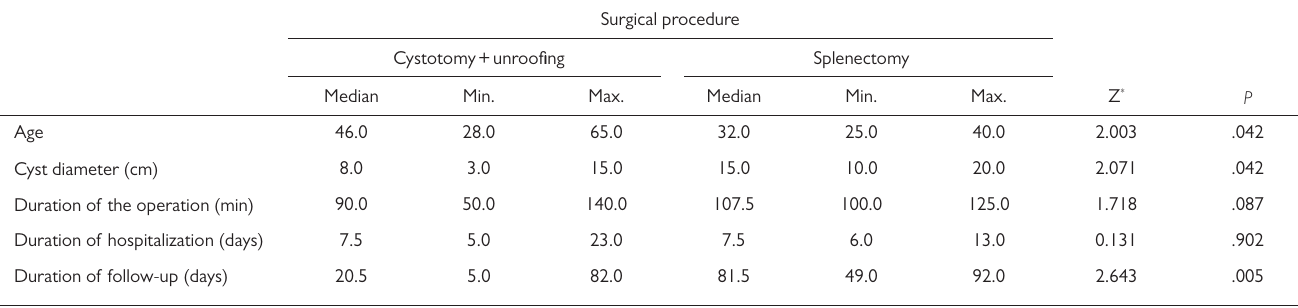
Table 3. Comparison of Numerical Variables Between Patients Undergoing Splenectomy and Spleen-Preserving